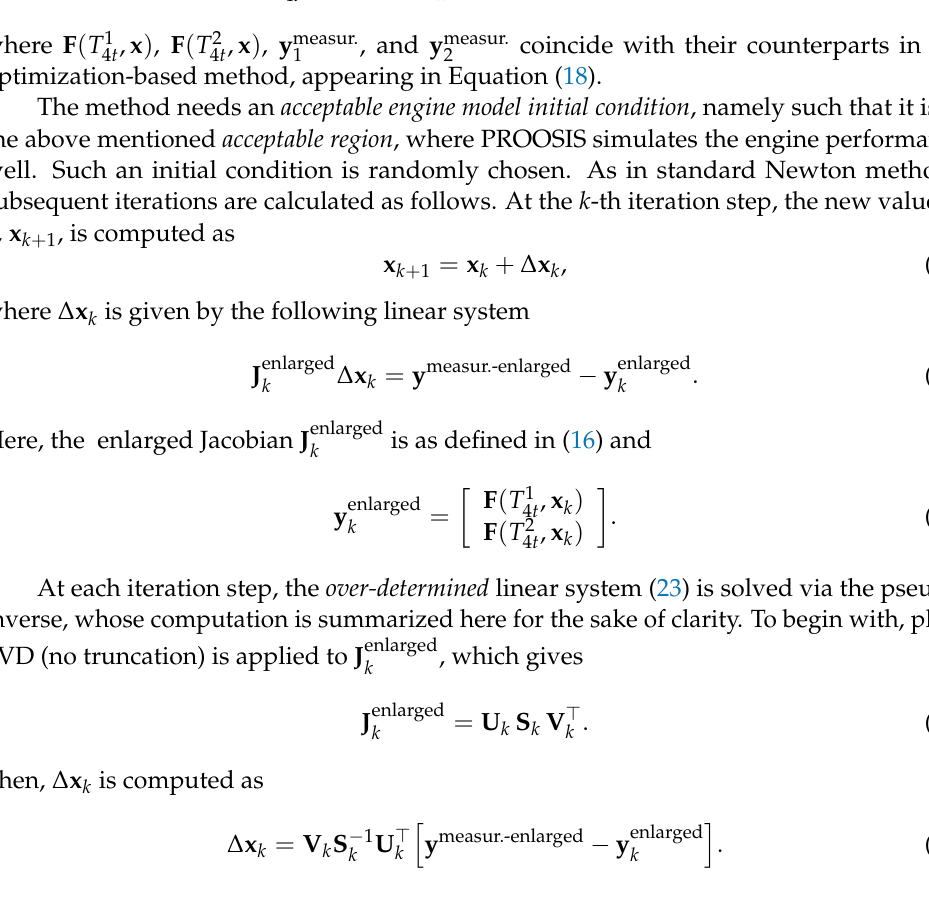
Figure 6. Counterpart of Figure 5 for the present case in which ( T 1 with the